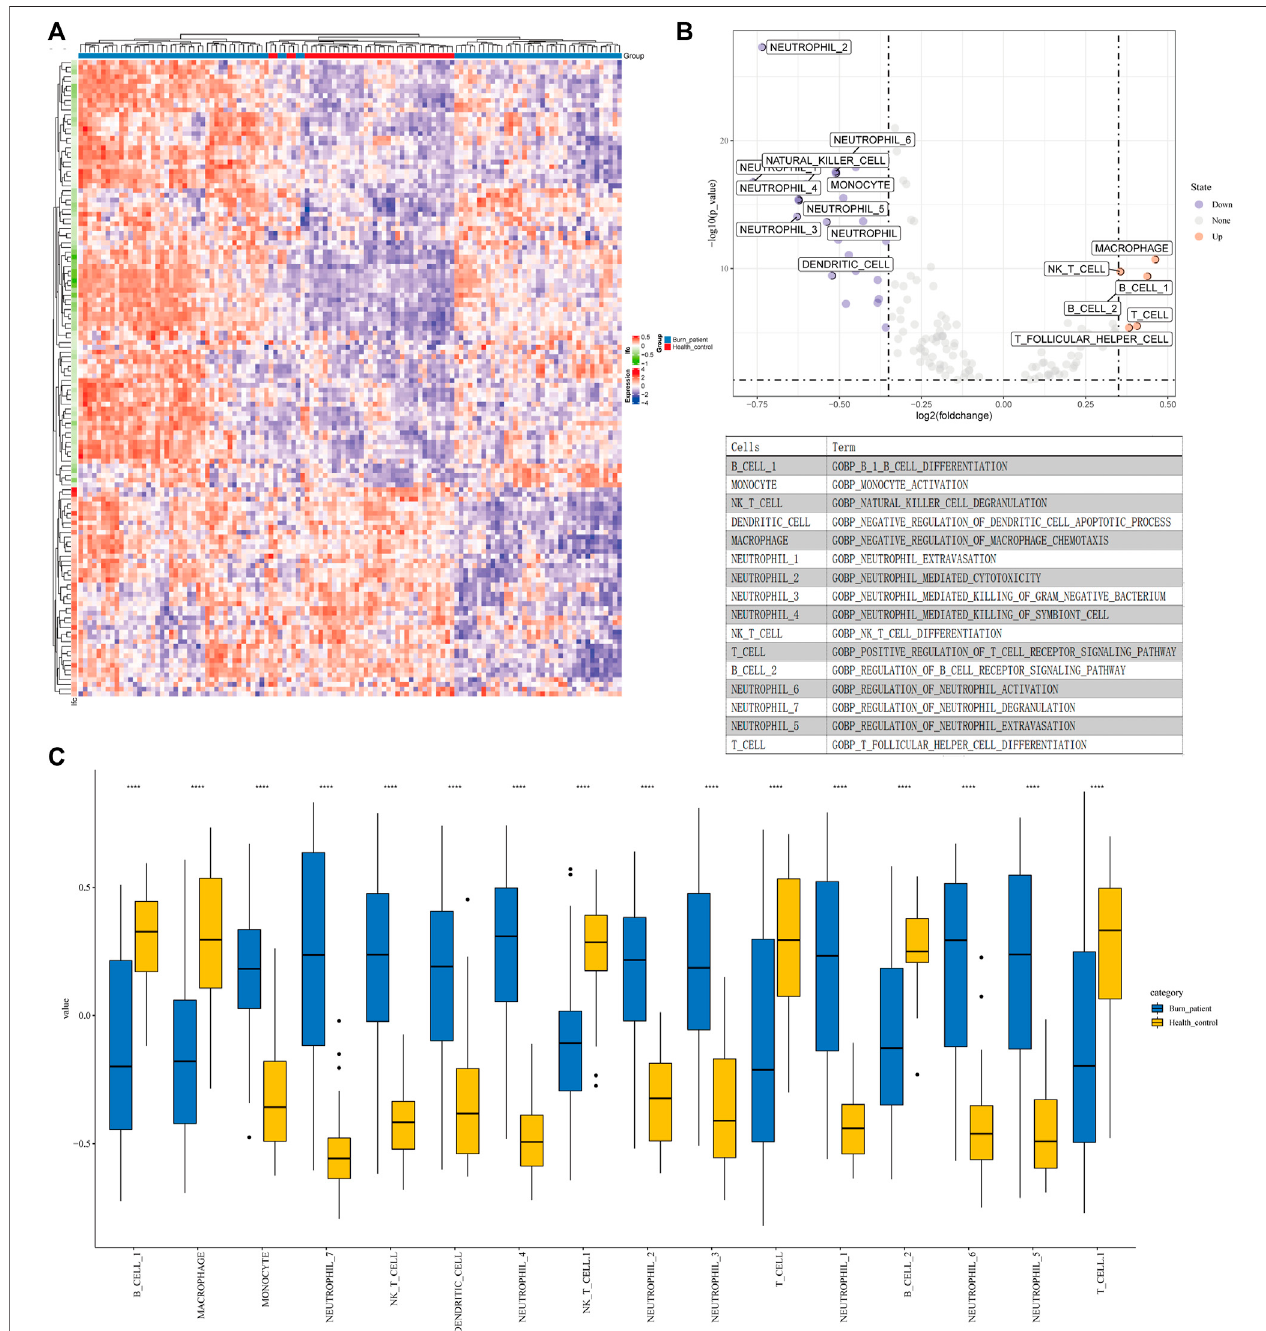
FIGURE 2 | Results of GSVA and CIBERSORT (A) Heat map of 203 GO terms between severe burns and controls. (B,C) Different terms of GSVA with |logFC| > 0.35, p < 0.05.